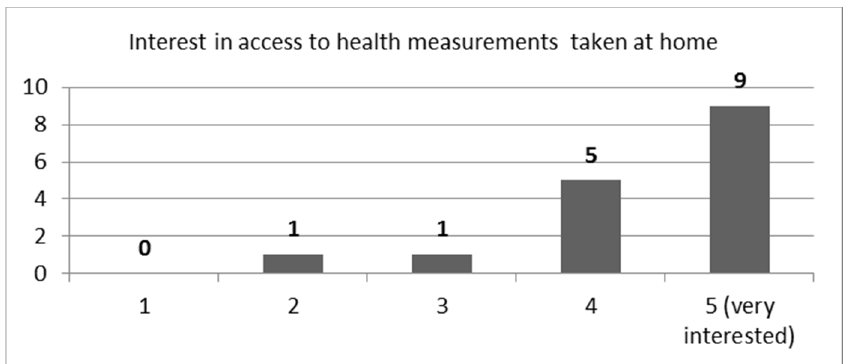
Figure 5. Distribution of rating scores for interest in having direct access to health measurement results from such devices.